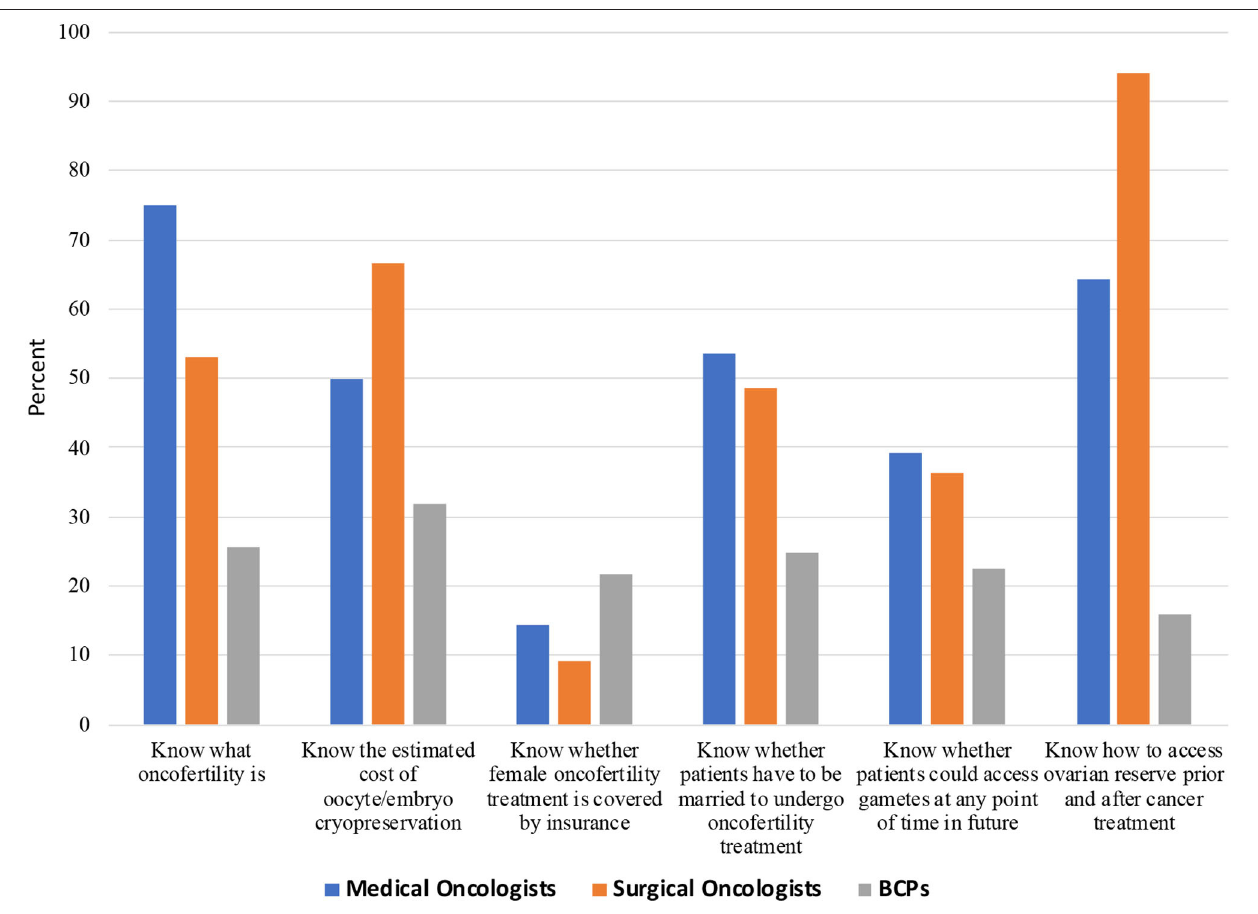
FIGURE 1 | Knowledge of oncofertility among Chinese medical oncologists, surgical oncologists, and breast cancer patients (BCPs).